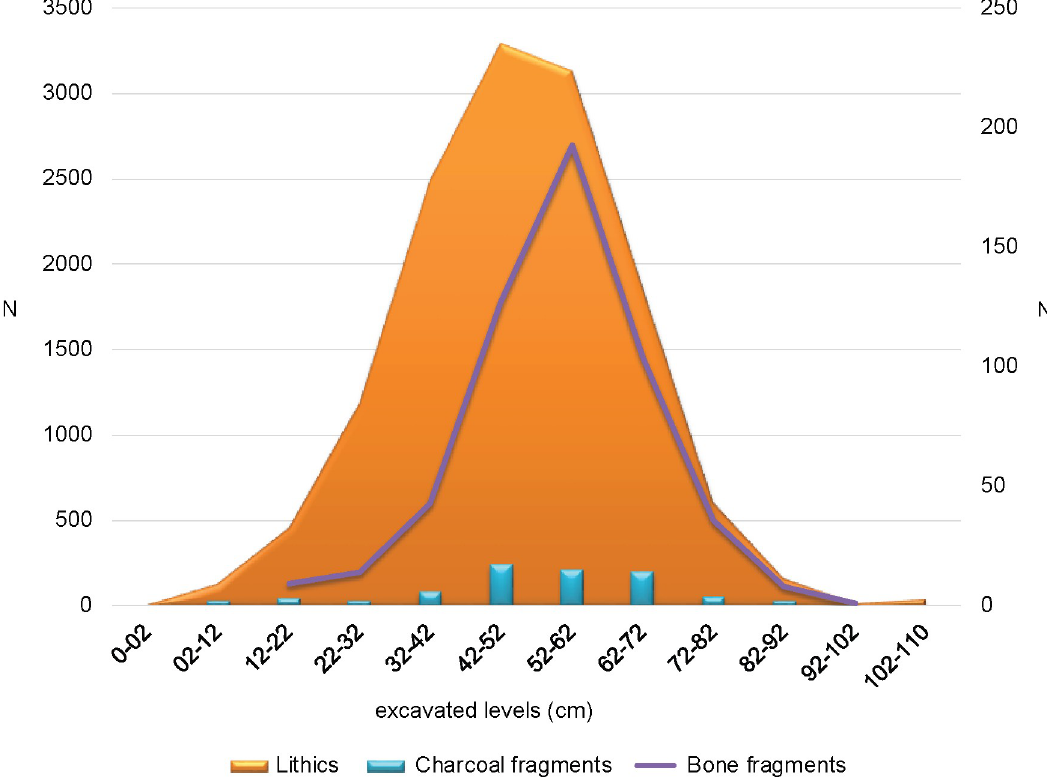
Fig 5. Distribution of archaeological material across excavated levels. Left scale is for lithic specimens (complete and fragments), right scale is for bone and charcoal fragments.